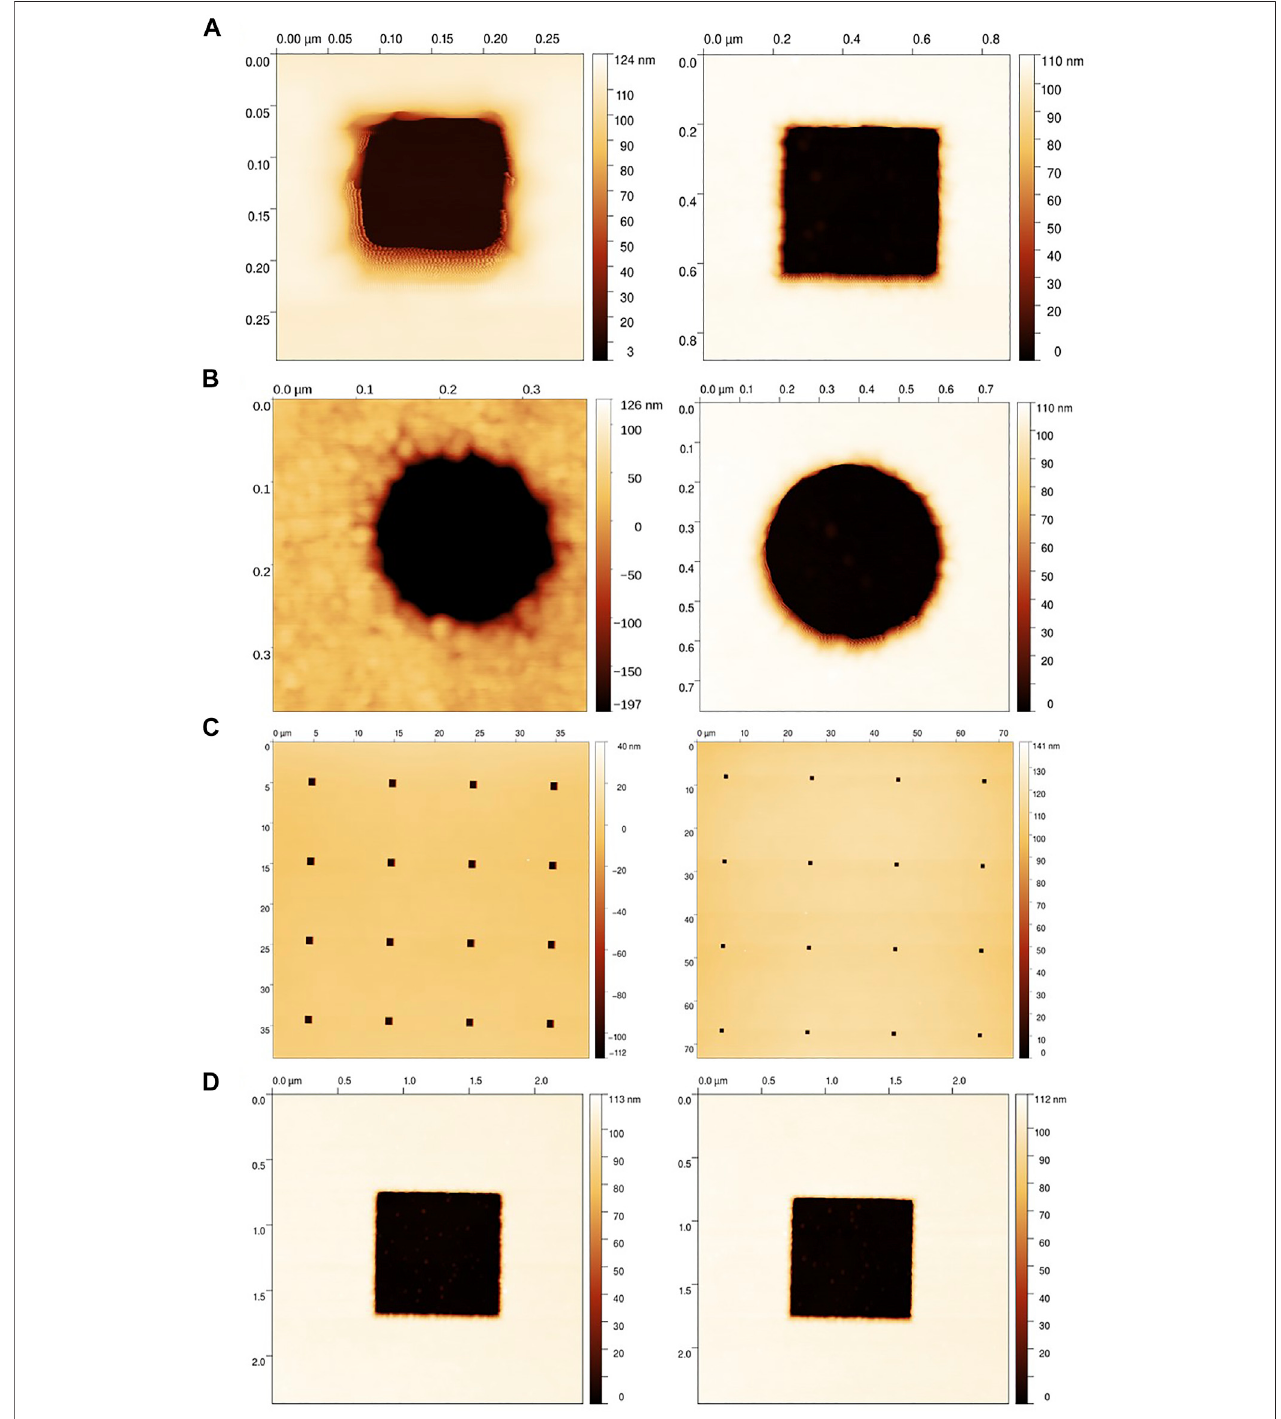
FIGURE 9 | AFM measurements of structures (A) B4 and B6, (B) C4 and C6, and (C) D4 and D9 with (D) details of single squares.